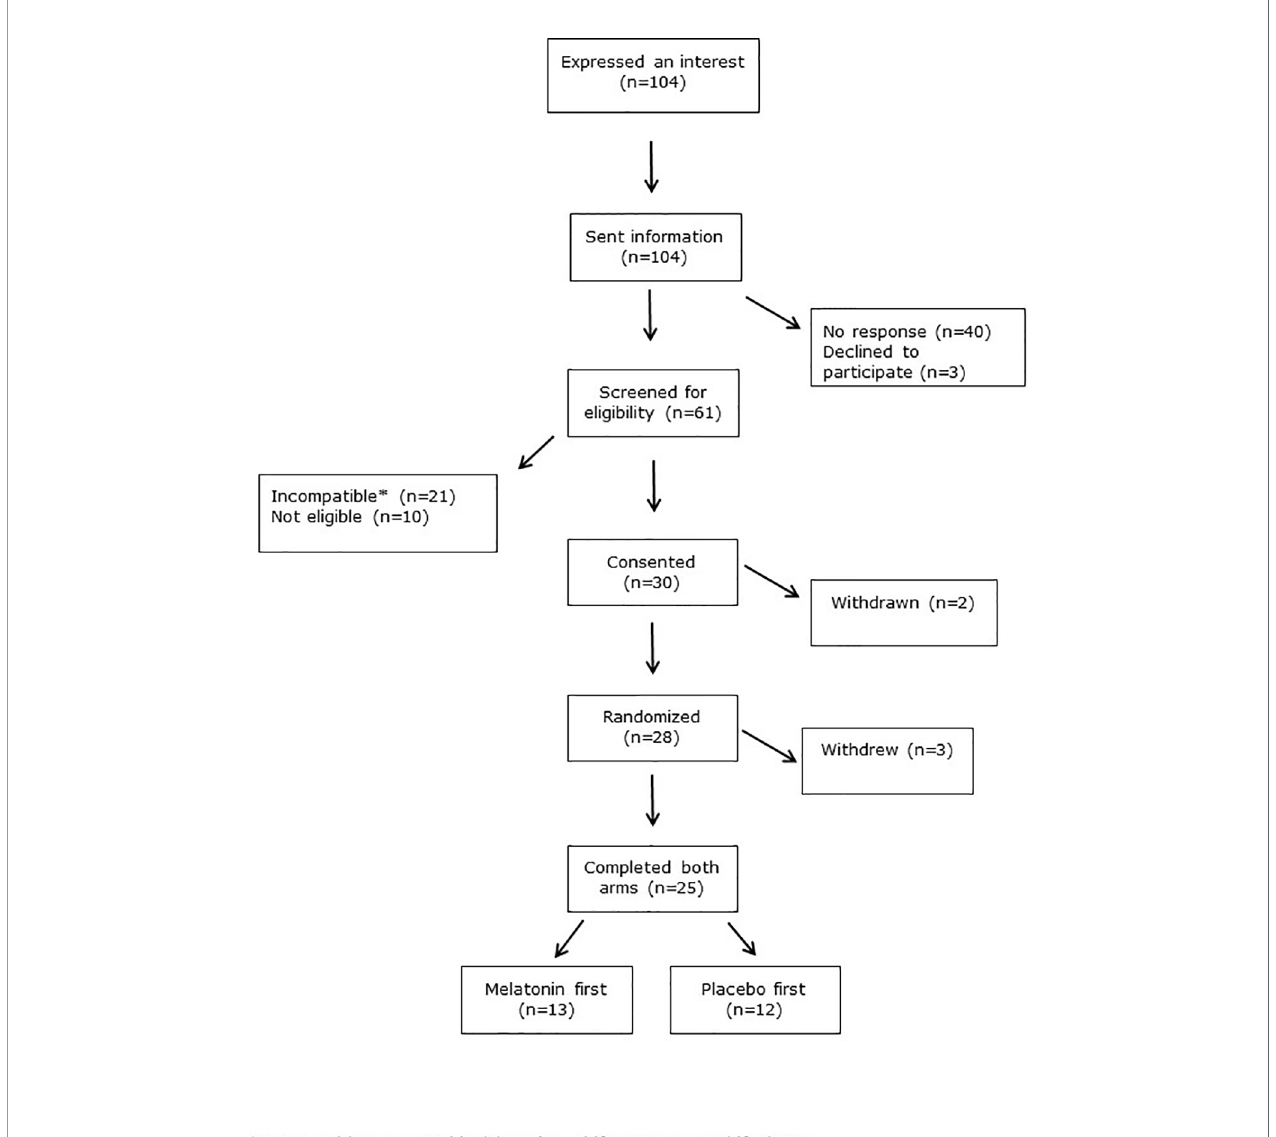
FIGURE 2 | CONSORT